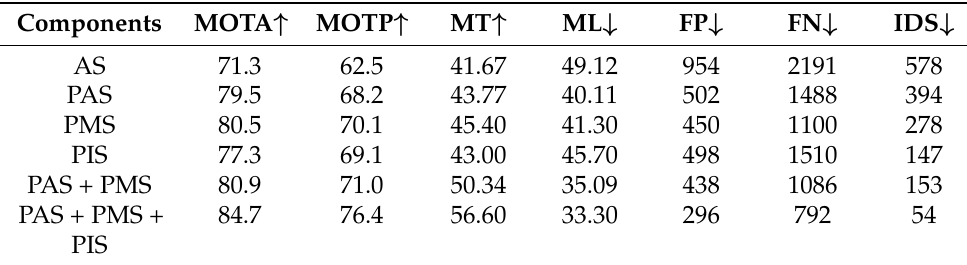
Table 1. Comparison of different components of Pose-based Triple Stream Network (PTSN) on the VolleyTrack.